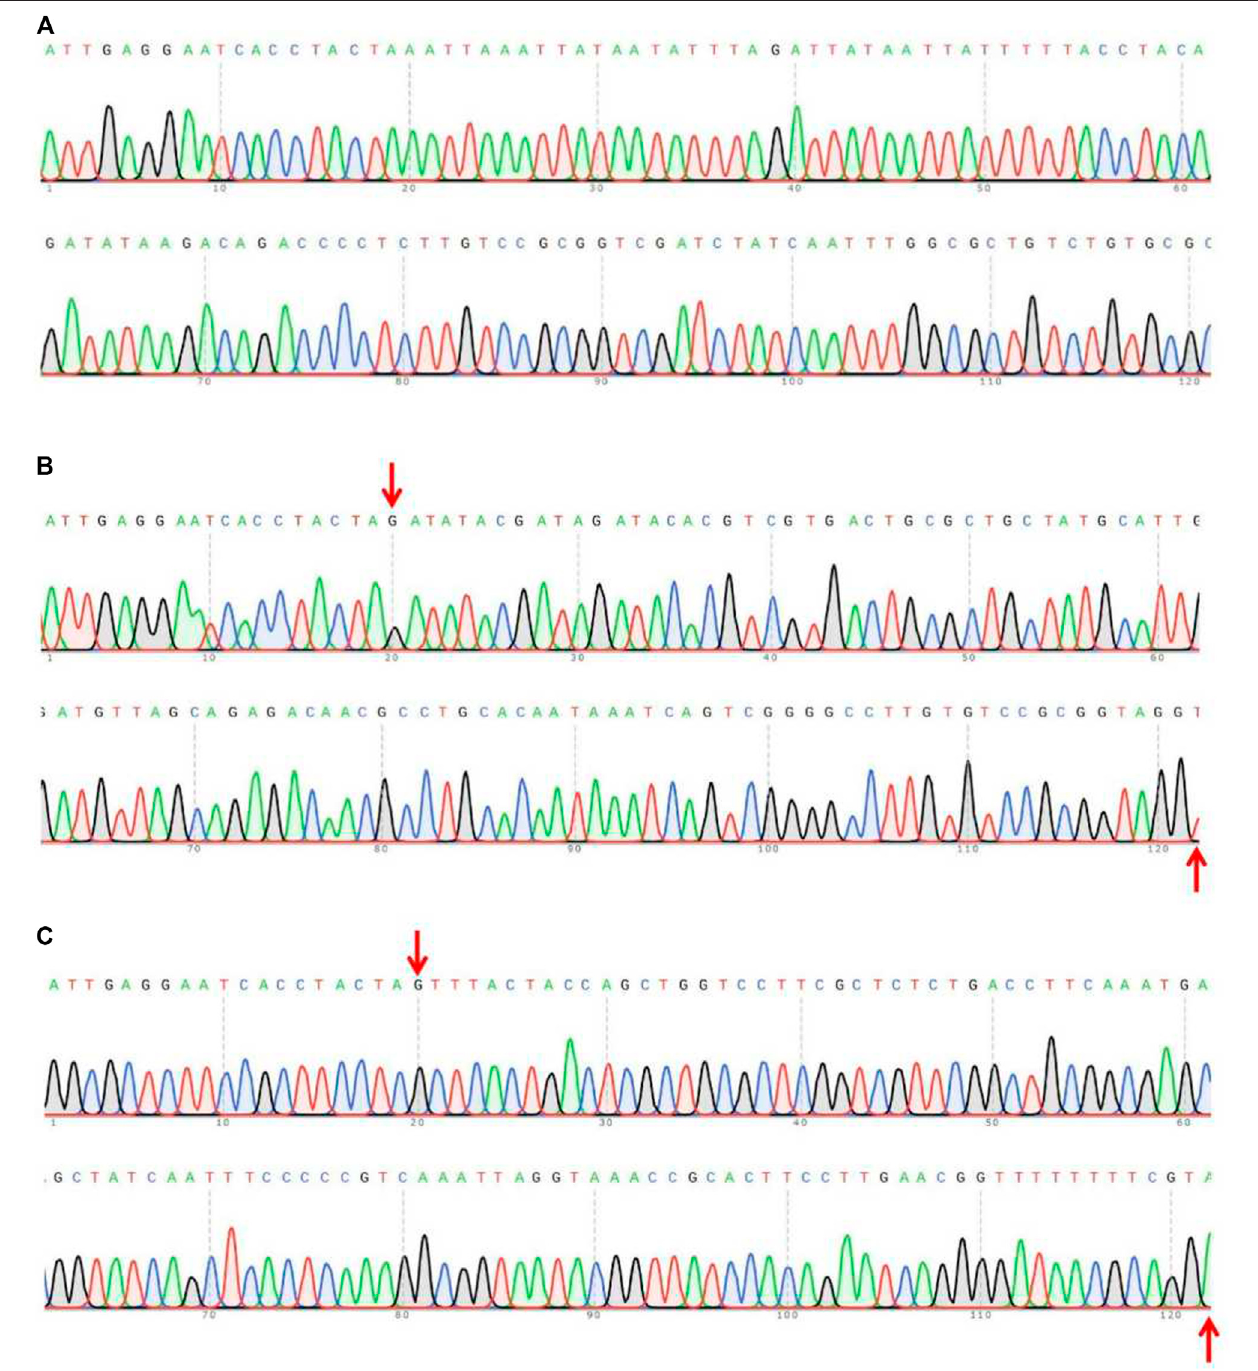
FIGURE 6 | Part sequences of wild-type (A) and the garbled exon 3 of Tuta absoluta cinnabar in the F1 generation (B,C) . The fragments between the red arrows represent the garbled bases.